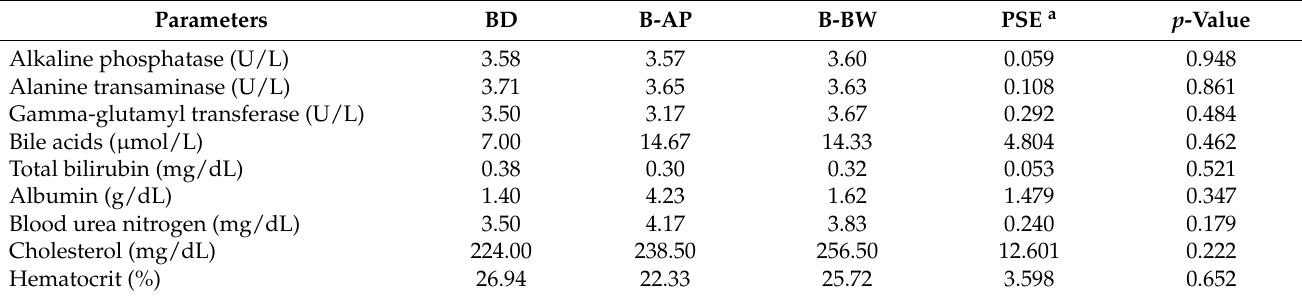
Table 7. Hematological parameters of channel catfish cultured in flow-through system for 8